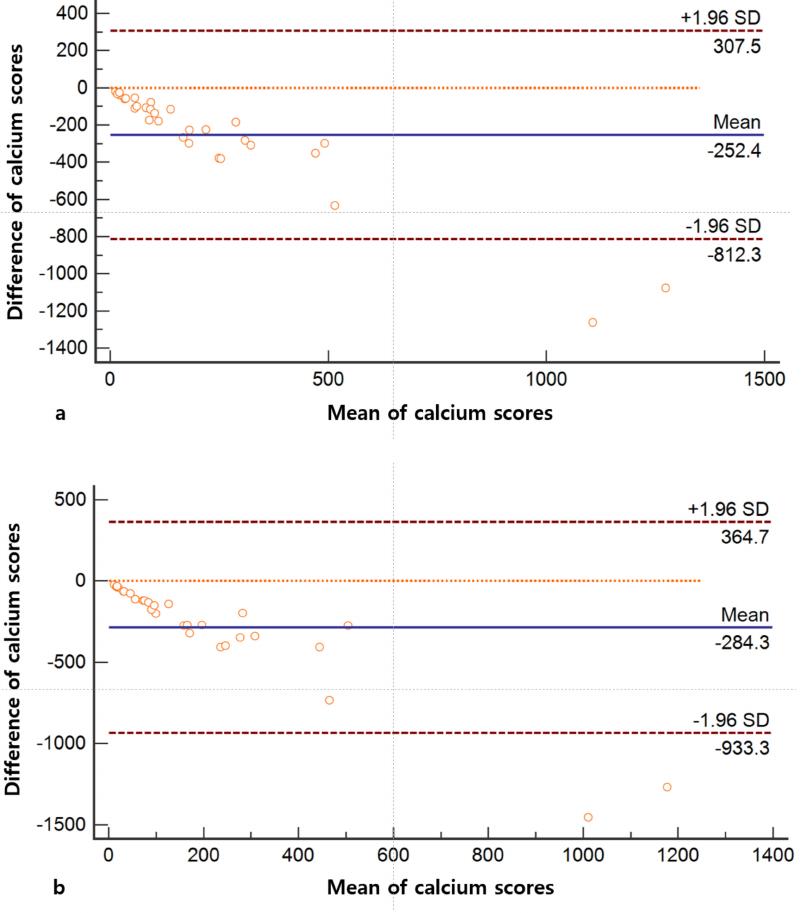
Figure 5. Bland-Altman plots of the coronary calcium-scoring CT and chest dual energy CT. Bland-Altman plots between the coronary calcium-scoring CT and chest dual energy CT with 1.25 mm slice thickness ( a ) and 2.5 mm slice thickness ( b